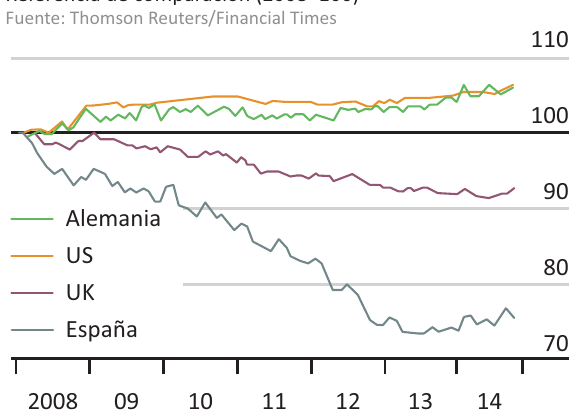
Figure 5. Real Wages 2008–2014. The average Spaniard lost 25% of his/her real salary in that period. Source: Thomson Reuters/Financial Times, in Idealista